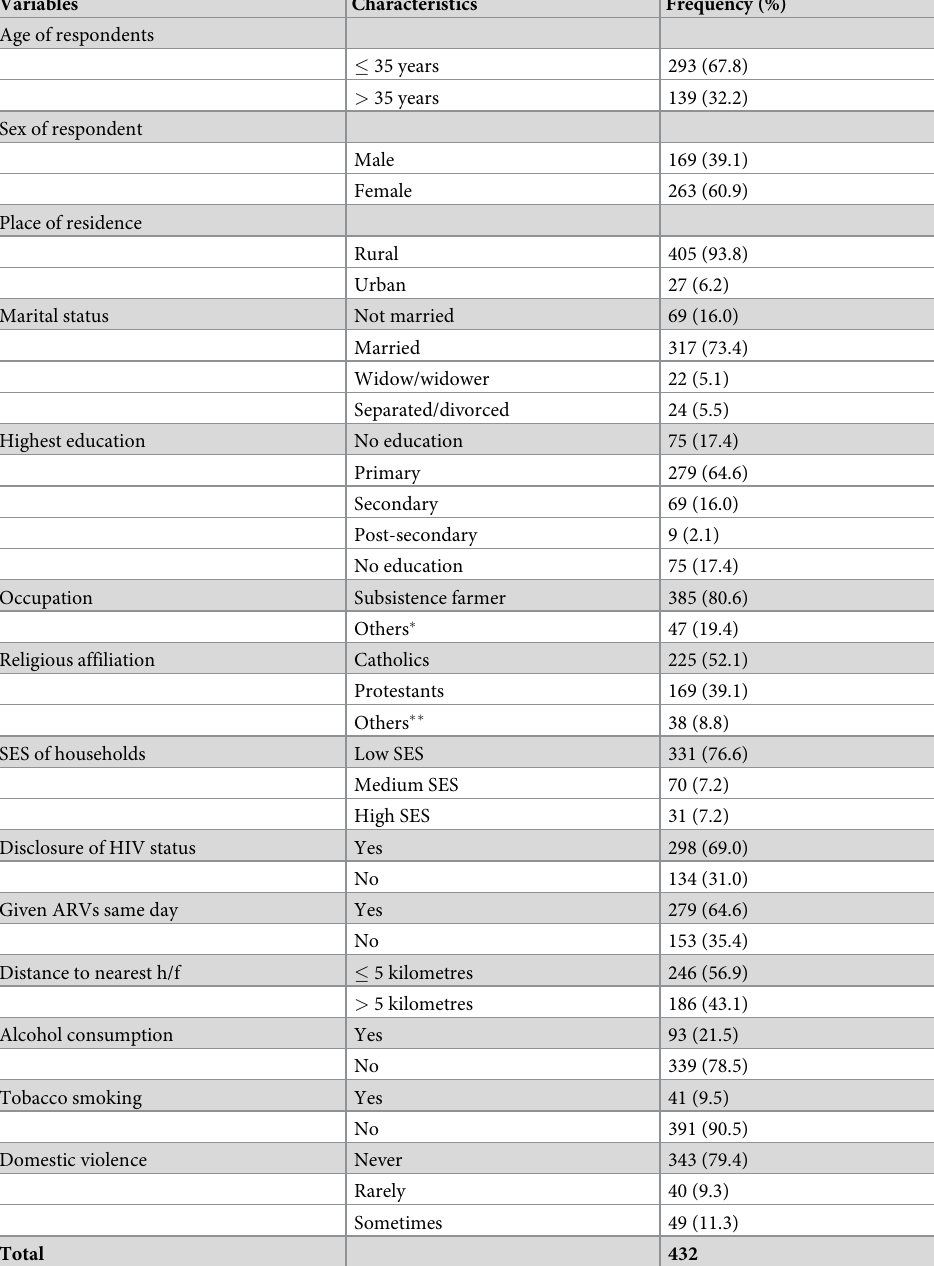
Table 1. Distribution of participants’ characteristics, Alebtong district (N =